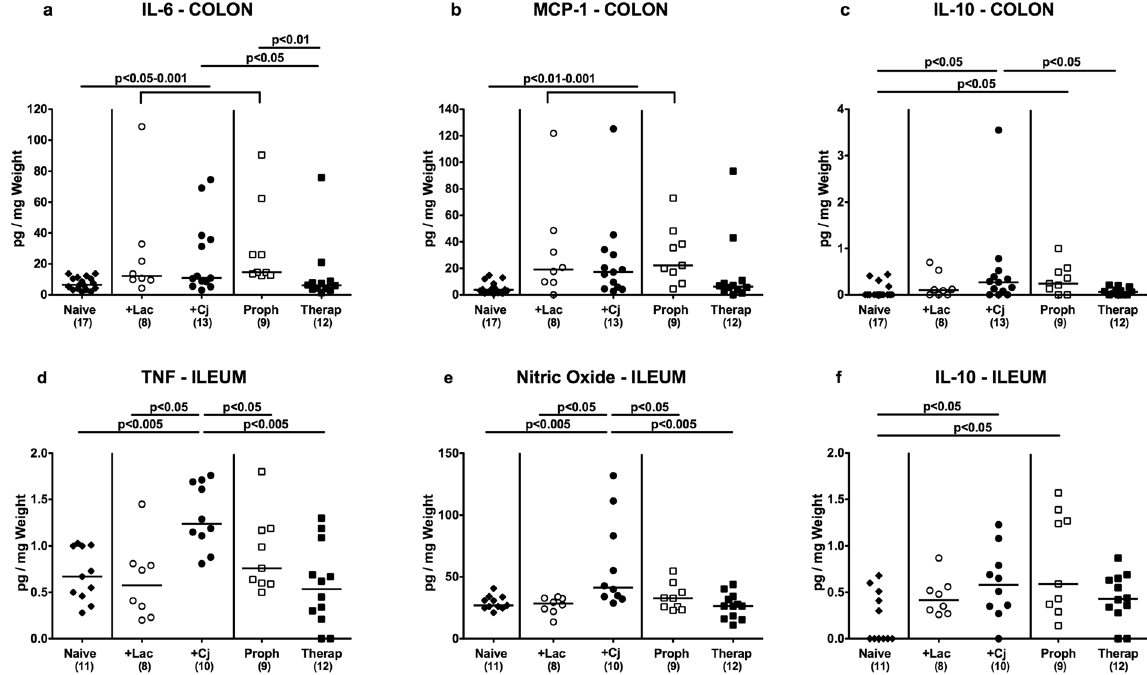
Figure 4. Intesinal secretion of pro- and anti-inflammatory mediators in C . jejuni strain 81–176 and/or L . johnsonii reassociated secondary abiotic mice. Secondary abiotic mice were perorally infected with C . jejuni strain 81–176 (Cj) and associated with L . johnsonii (Lac) either 14 days before (prophylactic regimen, Proph; white squares) or 7 days thereafter (therapeutic regimen, Therap; black squares) and compared to mono-associated mice ( + Lac, white circles; + Cj, black circles). Colonic ( a ) IL-6, ( b ) MCP-1 and ( c ) IL-10 concentrations as well as ileal ( d ) TNF, ( e ) nitric oxide and ( f ) IL-10 secretion were determined in ex vivo biopsies derived at days 21 or 28 following initial C . jejuni or L . johnsonii infection, respectively. Naive (N) mice (black diamonds) served as uninfected controls. Medians (black bars), levels of significance (p-value) determined by one-way ANOVA test followed by Tukey post-correction test for multiple comparisons and numbers of analyzed animals (in parentheses) are indicated. Data were pooled from three independent